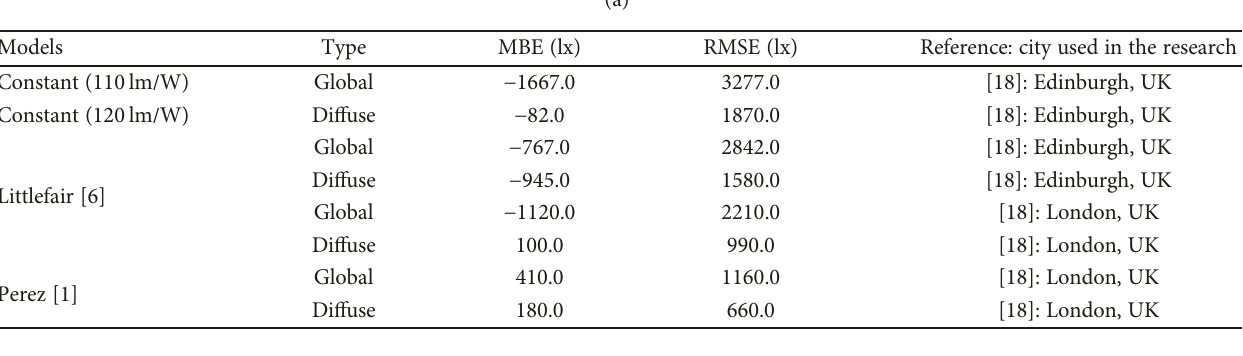
Table 1: Performance summary of various luminous e ffi cacy models in various